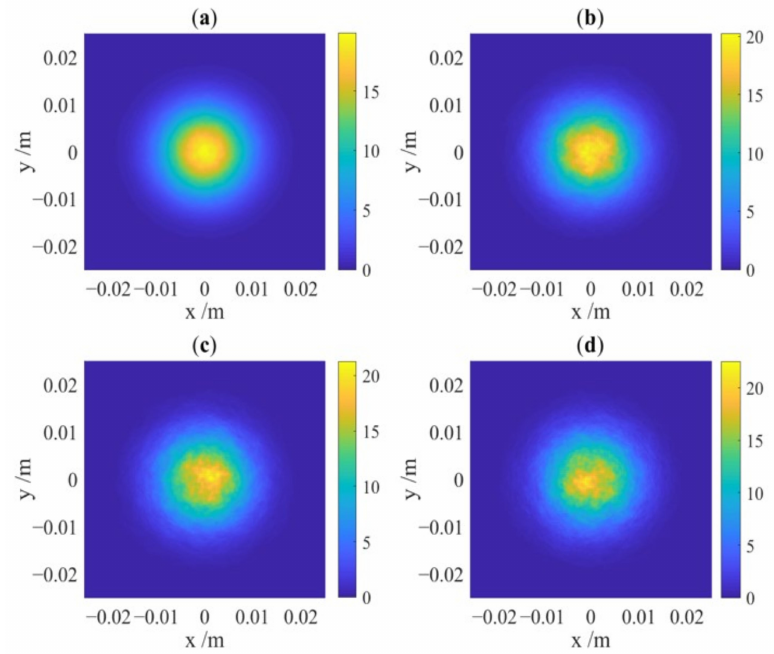
Figure 6. Intensity distributions with turbulence properties of ( a ) ε = 10 − 8 m 2 /s 3 , χ T = 10 − 5 K 2 /s, ω = − 0.5; ( b ) ε = 10 − 10 m 2 /s 3 , χ T = 10 − 5 K 2 /s, ω = − 0.5; ( c ) ε = 10 − 8 m 2 /s 3 , χ T = 10 − 4 K 2 /s, ω = − 0.5; ( d ) ε = 10 − 8 m 2 /s 3 , χ T = 10 − 5 K 2 /s, ω = −